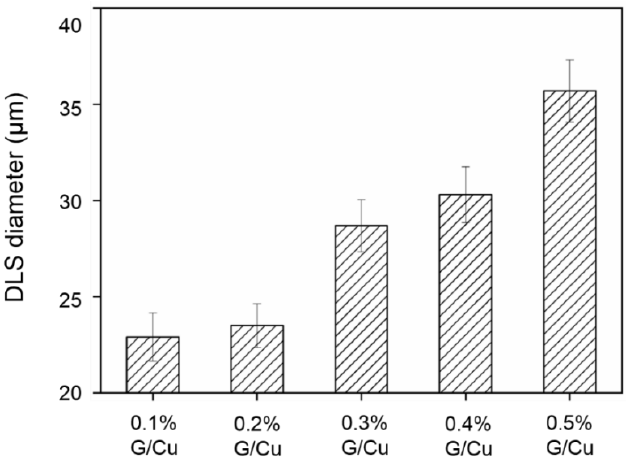
Figure 1. DLS diameter of nano-graphene/Cu slurry.